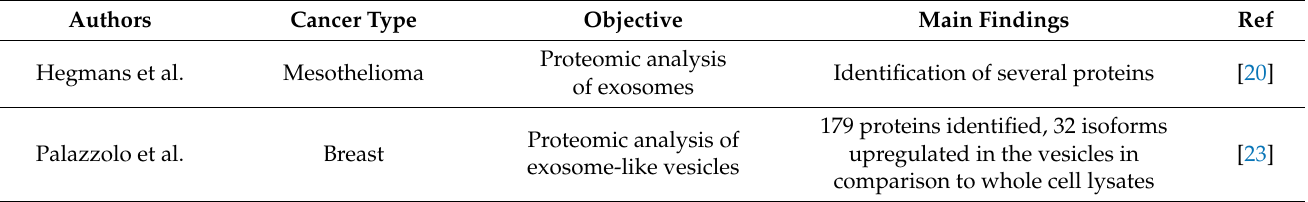
Table 1. Objectives and main findings of the MALDI-TOF applications for the analysis of tumor derived